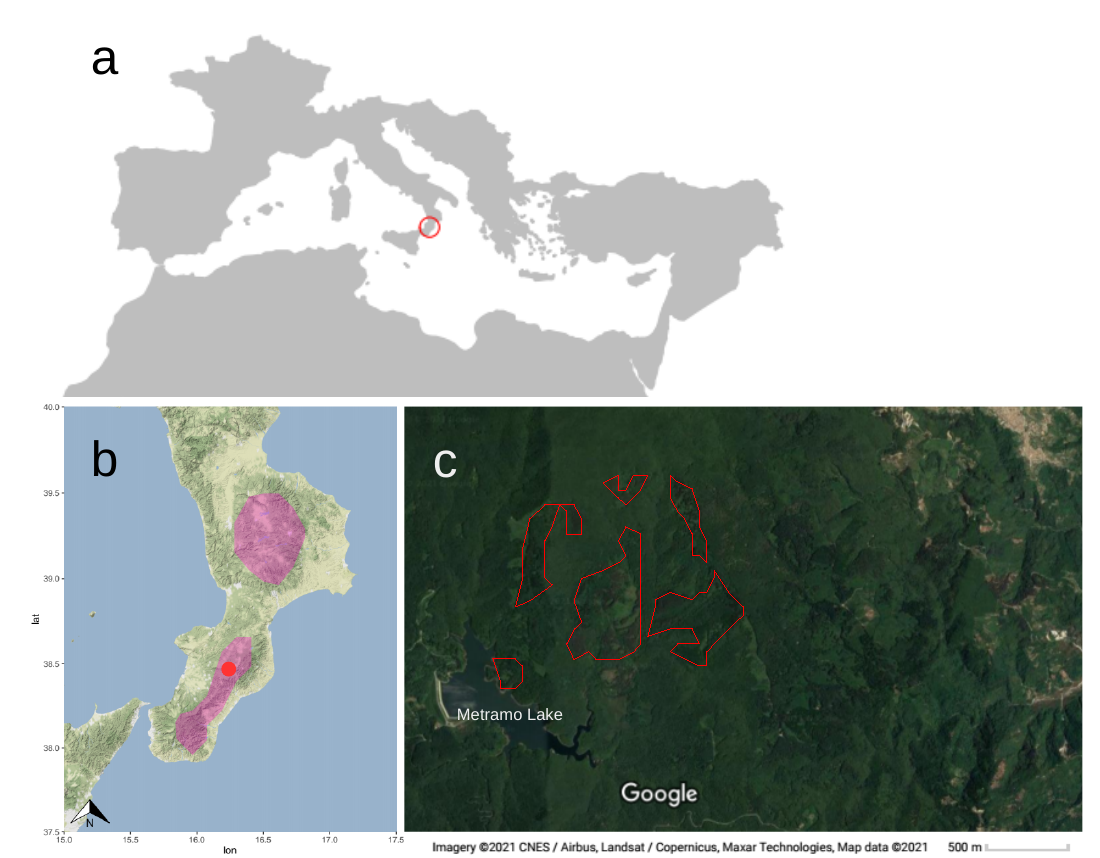
Figure 1. Map position of the study area of Prateria (red symbols) in the center of the Mediterranean region ( a , b ) on the south-facing slope of the Serre mountains towards the Metramo Lake (San Pietro di Carid à , Reggio Calabria, Italy) ( c ). The approximate local distribution range of Pinus nigra subsp. laricio (adapted from the European Forest Genetic Resources Programme, EUFORGEN http://www.euforgen.org/species/pinus-nigra/ (accessed on 3 July 2021)) is shown in magenta coloring ( b ). Maps were drawn using the sf [27] and ggplot2 [28] packages in R